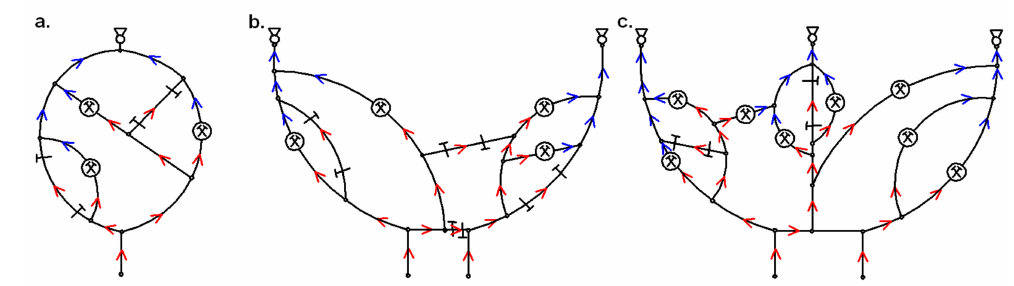
Figure 1. Canonical diagrams of ventilation networks with ( a ) simple structures, ( b ) complex structures and ( c ) highly complex structures